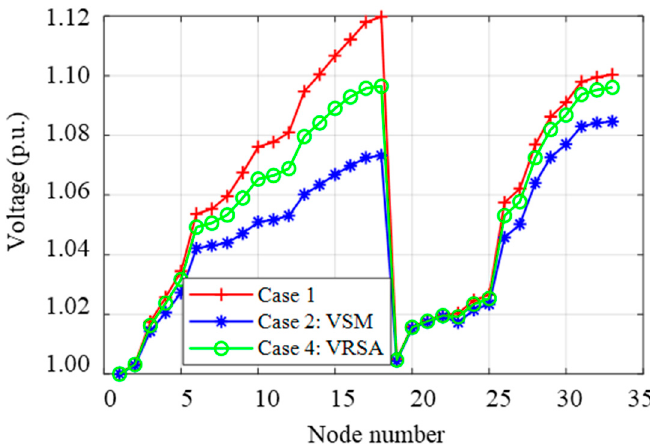
Figure 15. Voltage of the 33 nodes at time slot 40.